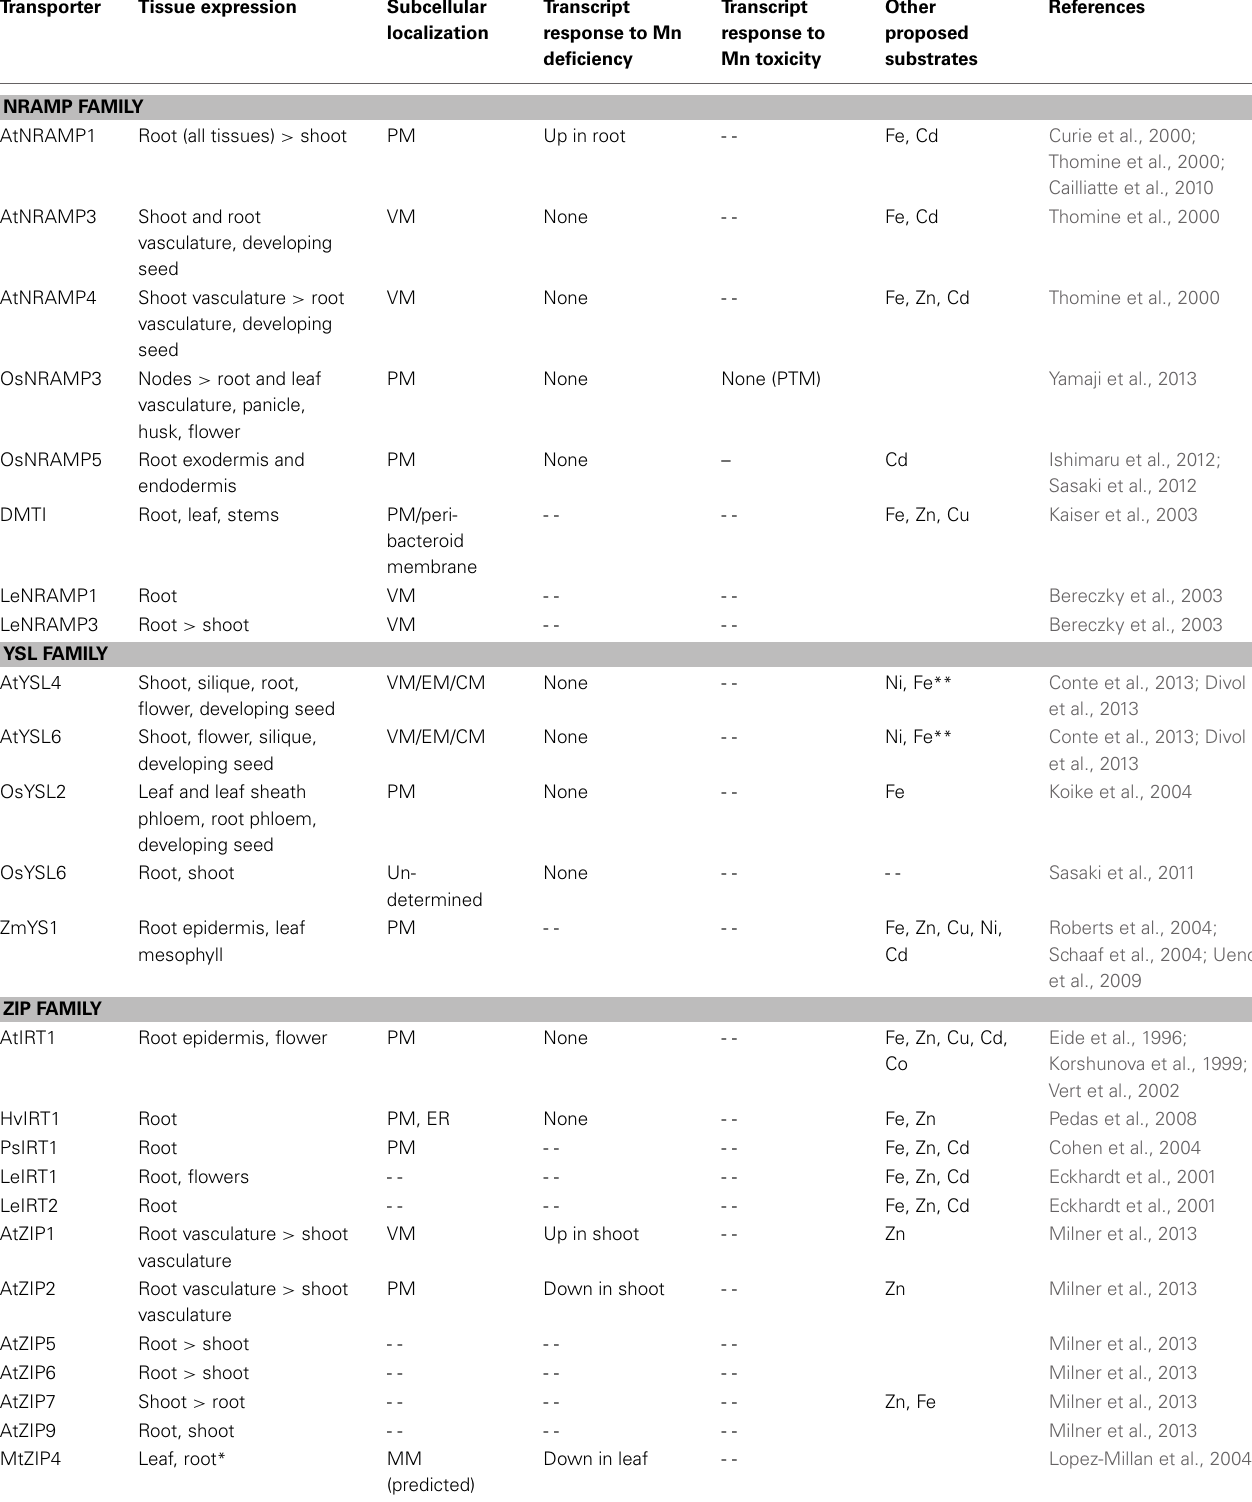
Table 1 | Putative Mn transporters referenced in the text.